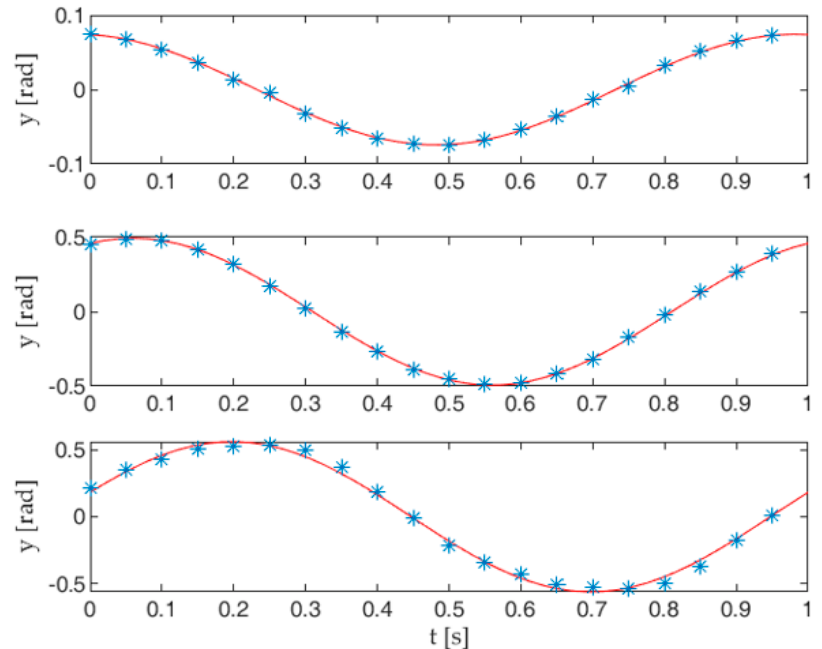
Figure A1. Interpolation of absolute link angles: the blue dots represent the values obtained by the tail postures, while the solid lines indicate the sine functions resulting from the interpolation.